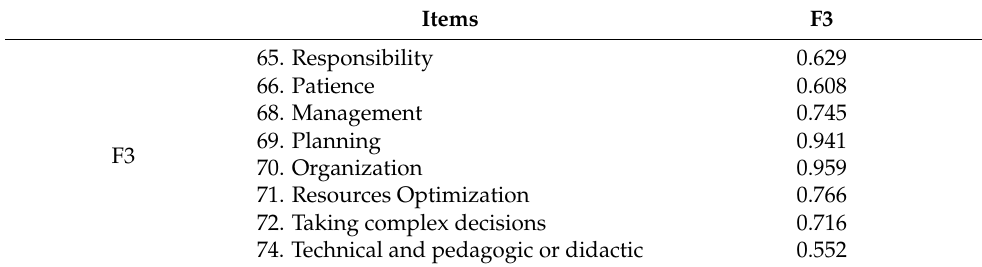
Table 7. Results of Factorial analysis: F3.